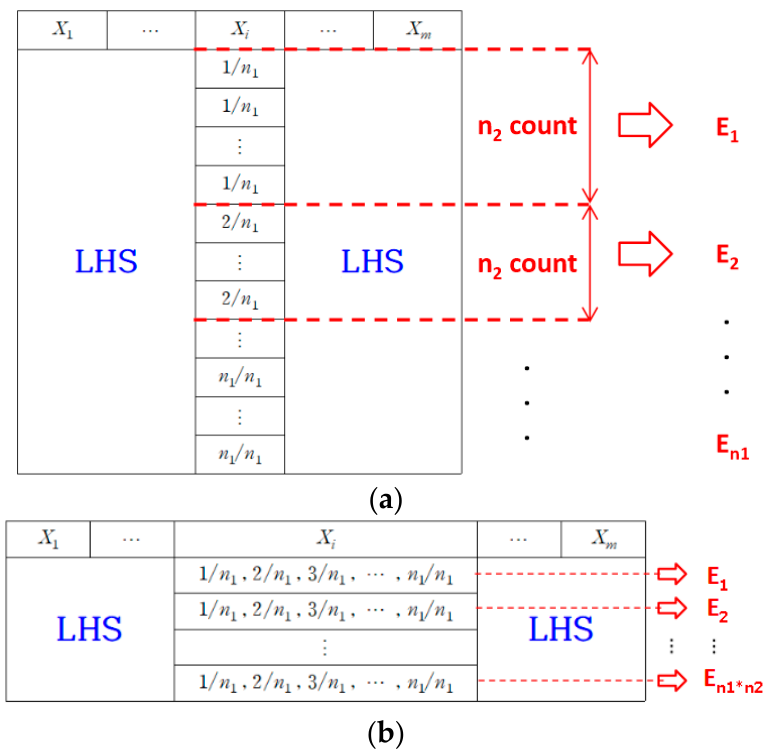
Figure 5. Modified LHS design. ( a ) For first ‐ order index calculation. ( b ) For total ‐ order index calculation.